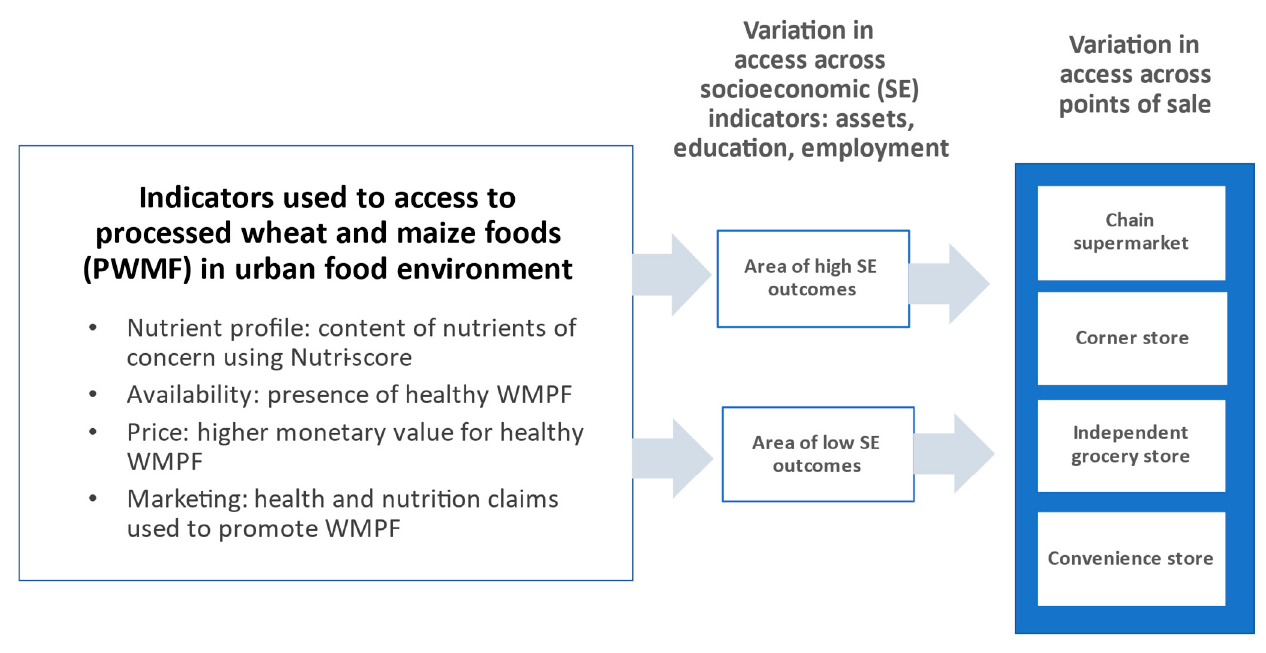
food Figure 1. Framework for assessing access to wheat and maize processed foods (WMPFs) in an urban food environment.